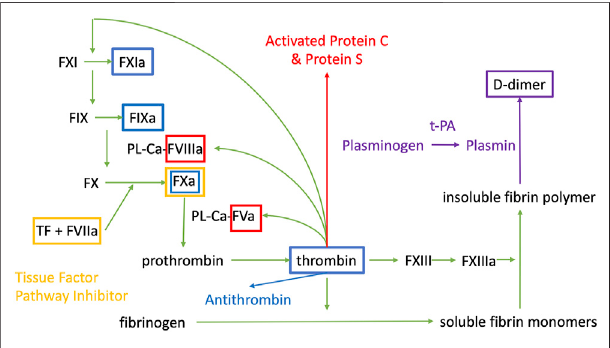
FIGURE 1 | Coagulation cascade. PL are phospholipids, Ca is Calcium, F is for Factor, a indicates that it is the activated form of the factor. t-PA is tissue plasminogen activator. The colour of the boxes correspond to the substance that is inhibiting the factor contained in the